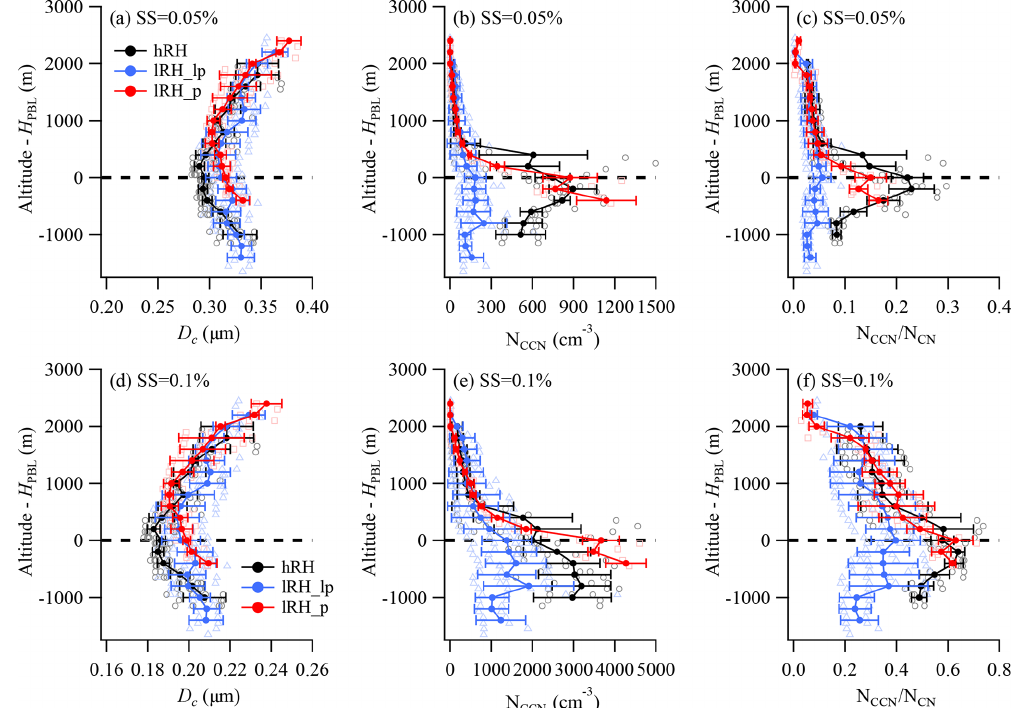
Figure 8. Vertical profiles of aerosol activation properties under lRH and hRH conditions; (a–c) critical diameter ( D c ), number concentration of CCN ( N CCN ), and the ratio of N CCN and N CN ( N CCN /N CN ) at supersaturation (SS) of 0.05%, using PCASP measured size distribution; (d–f) D c , N CCN , and N CCN /N CN at SS = 0 . 1%. The black, blue, and red lines denote the profiles under hRH, lRH_lp, and lRH_p conditions,